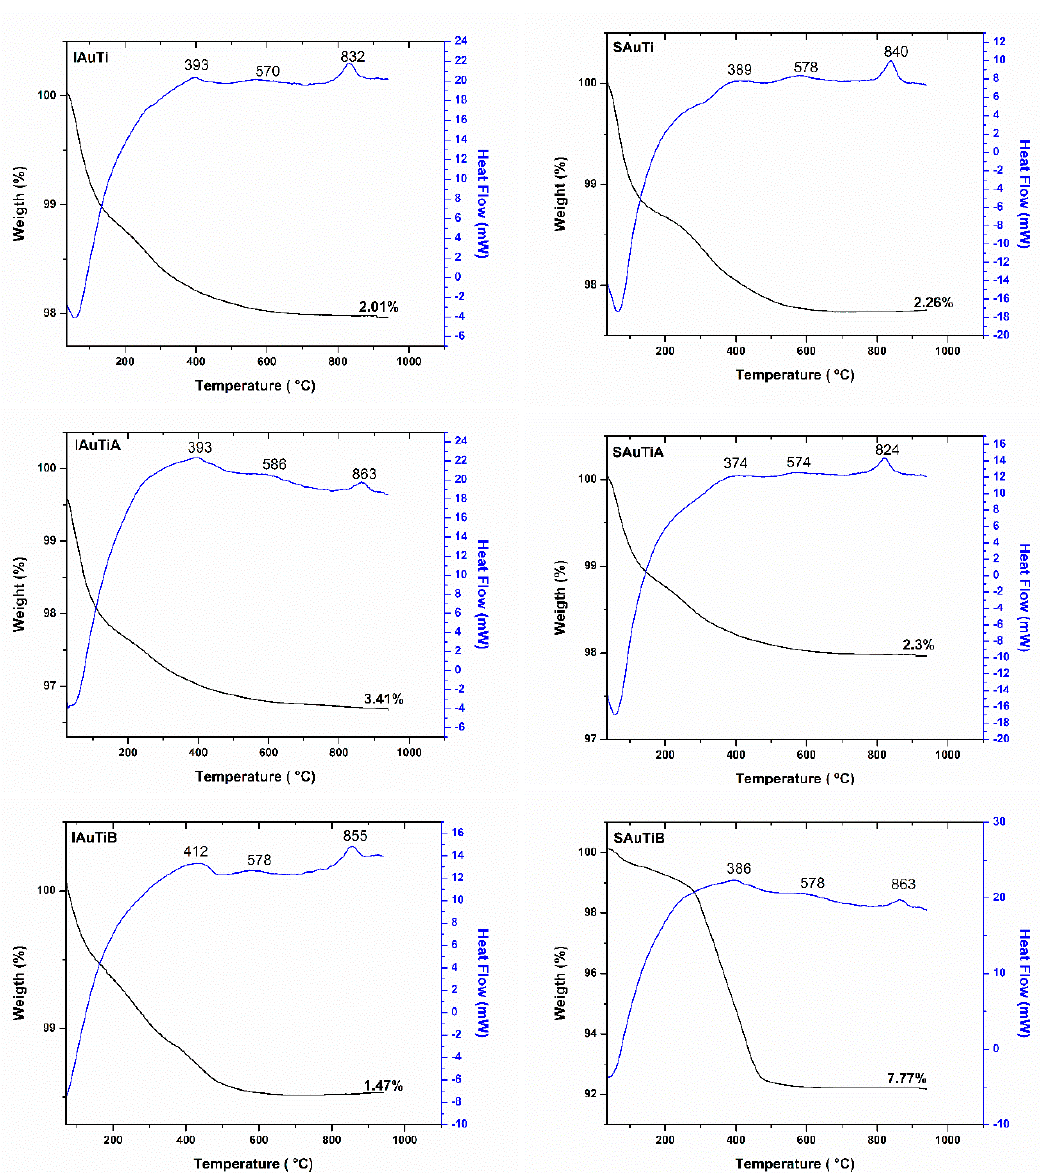
Figure 4. Thermogravimetric analysis of the materials synthesized by IiM and SiM.